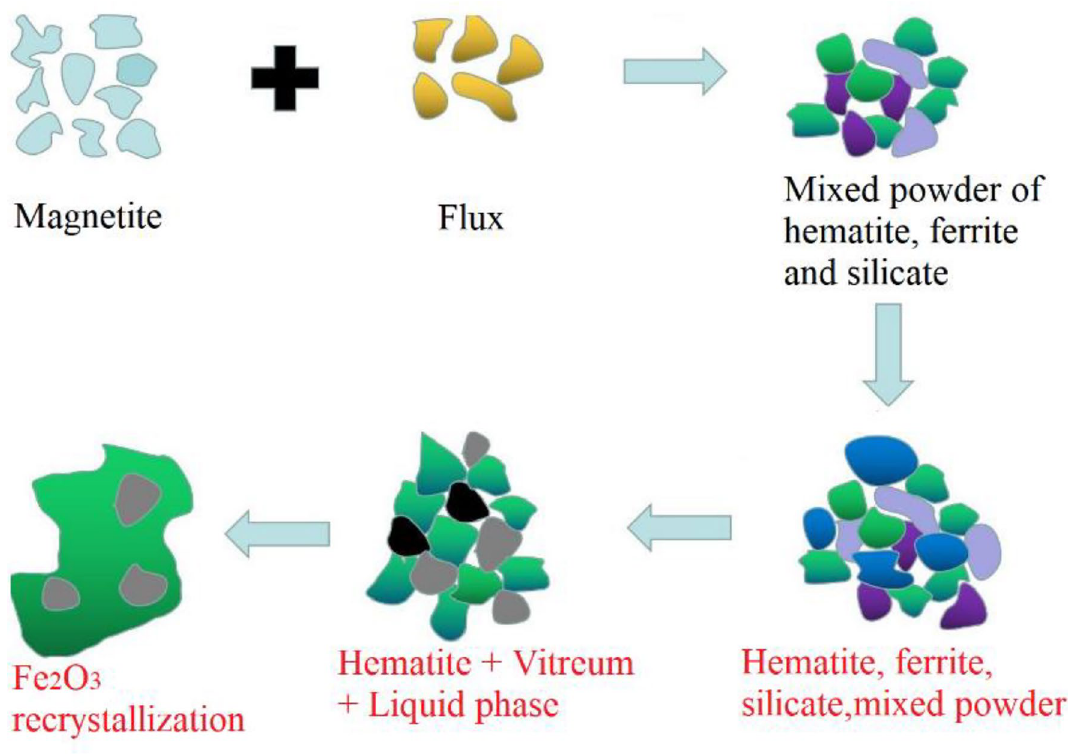
Figure 7. Ring formation mechanism of magnesian flux pellets in rotary